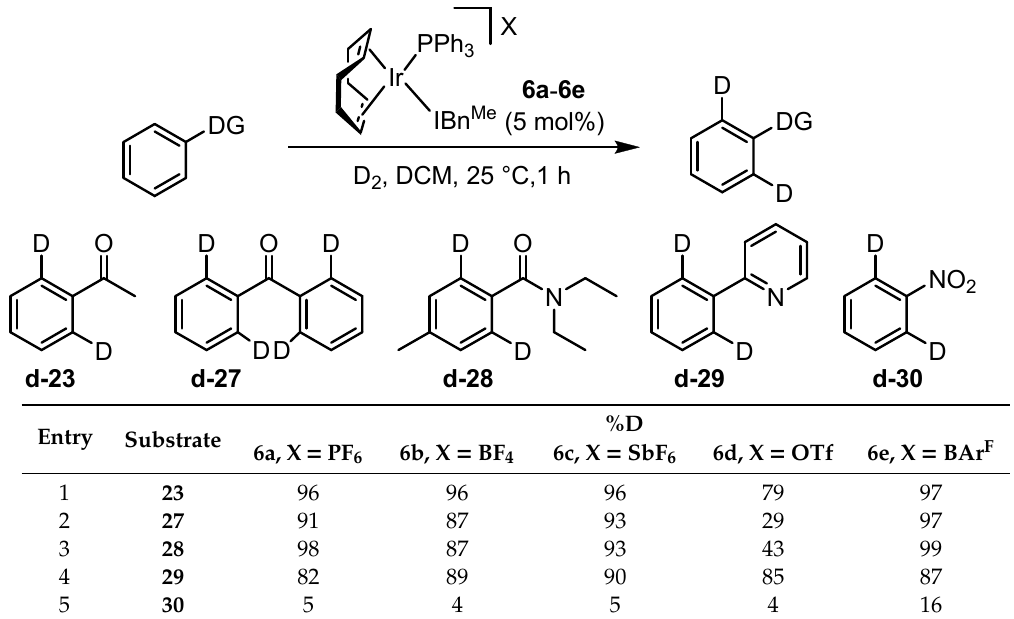
Table 5. Evaluation of counter-ion effects in IBn Me /PPh 3 complexes 6 .